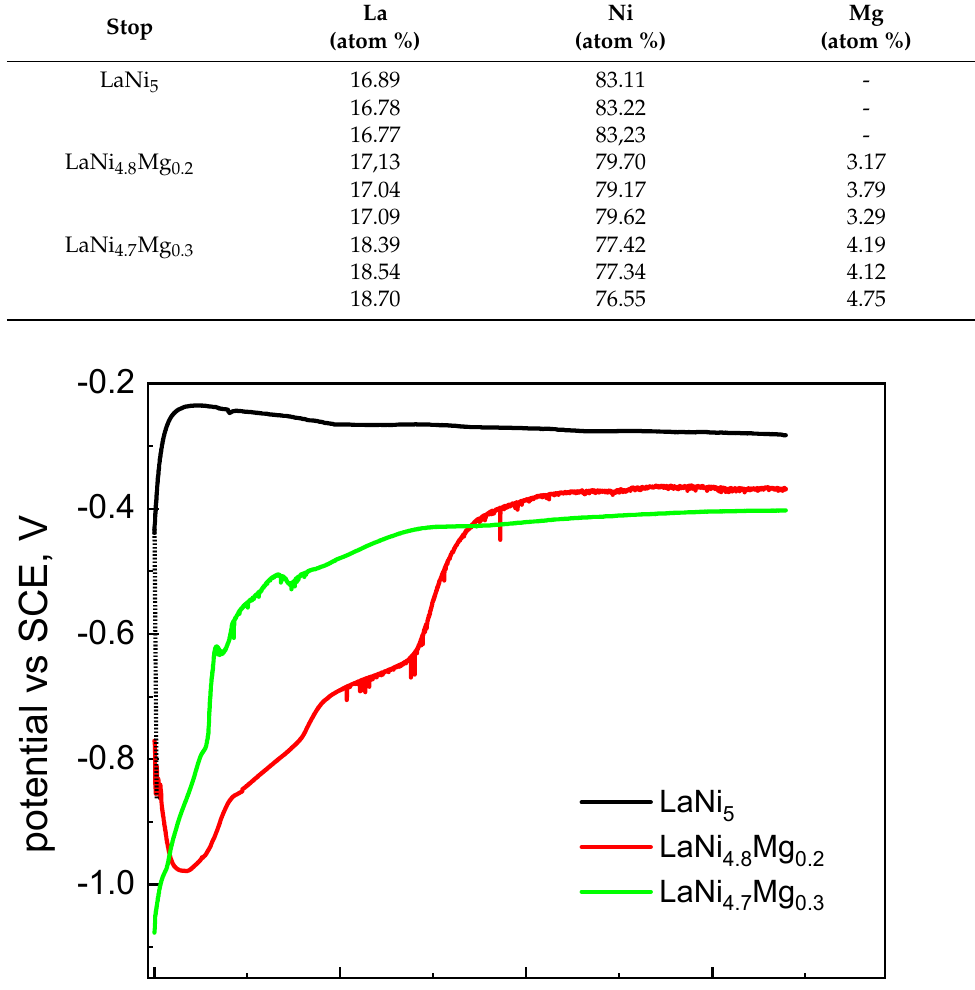
magnesium showed a greater tendency to corrosion from the thermodynamic point of